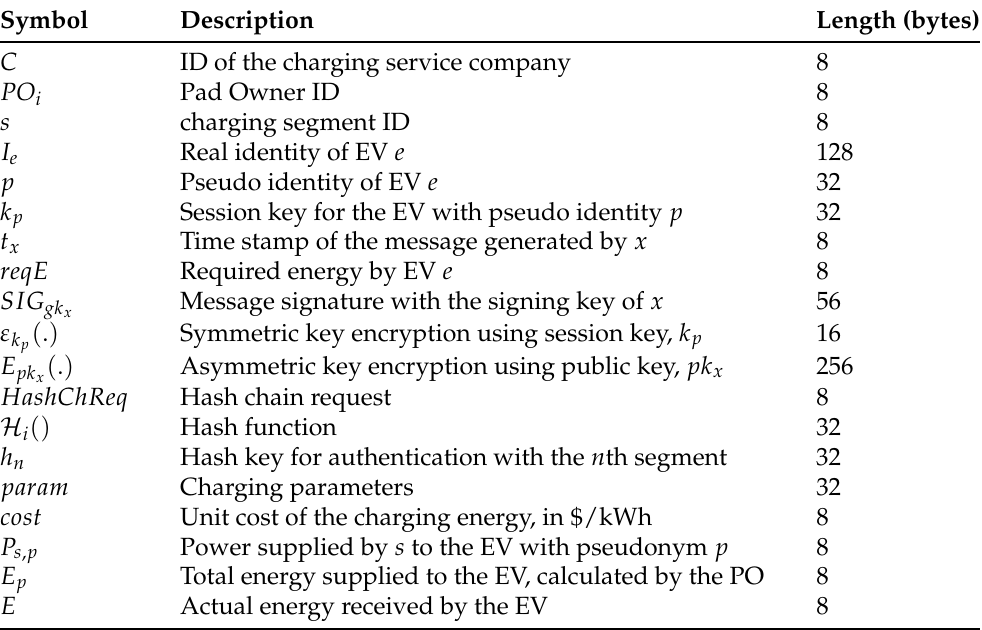
Table 1. Description and length, in bytes, of the different symbols used in the proposed authentication and billing